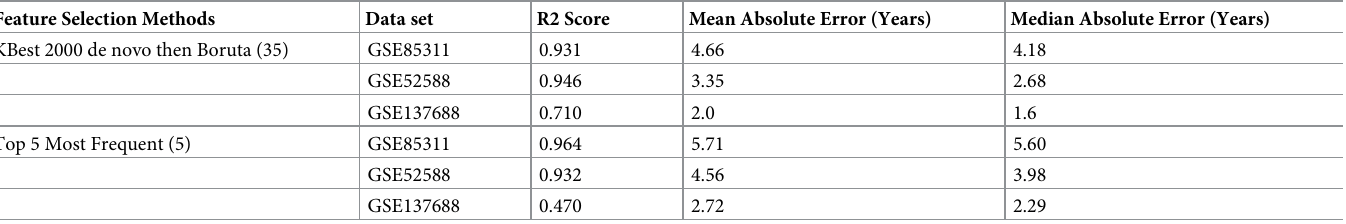
Table 3. Table showing the results of the two final models trained on the Hannum dataset (GSE40279) [6]) validated on external datasets: Horvath down syndrome blood dataset (GSE52588)[22], Martens exercise blood dataset (GSE85311)[24], and buccal dataset (GSE137688)[23]. Number of CpG sites/features in parentheses. Feature Selection